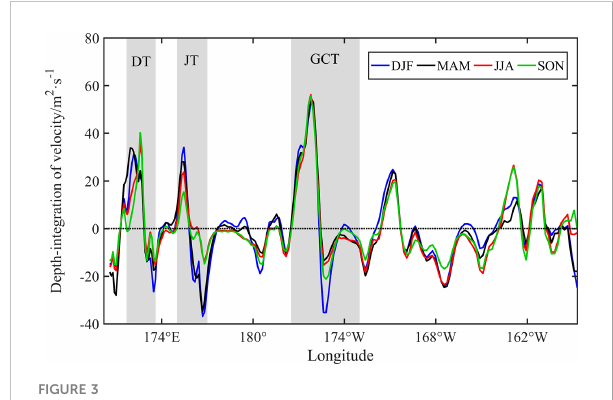
FIGURE 3 Climatological seasonal averages of depth-integrated cross-transect transports in m 2 ·s − 1 (positive, off-shelf; negative, on-shelf) along Transect 1. Gray areas indicate the DT, JT, and GCT. DJF, MAM, JJA, and SON denote December – January – February, March – April – May, June – July – August, and September – October – November, respectively. DT, Drygalski Trough; JT, Joides Trough; GCT, Glomar Challenger